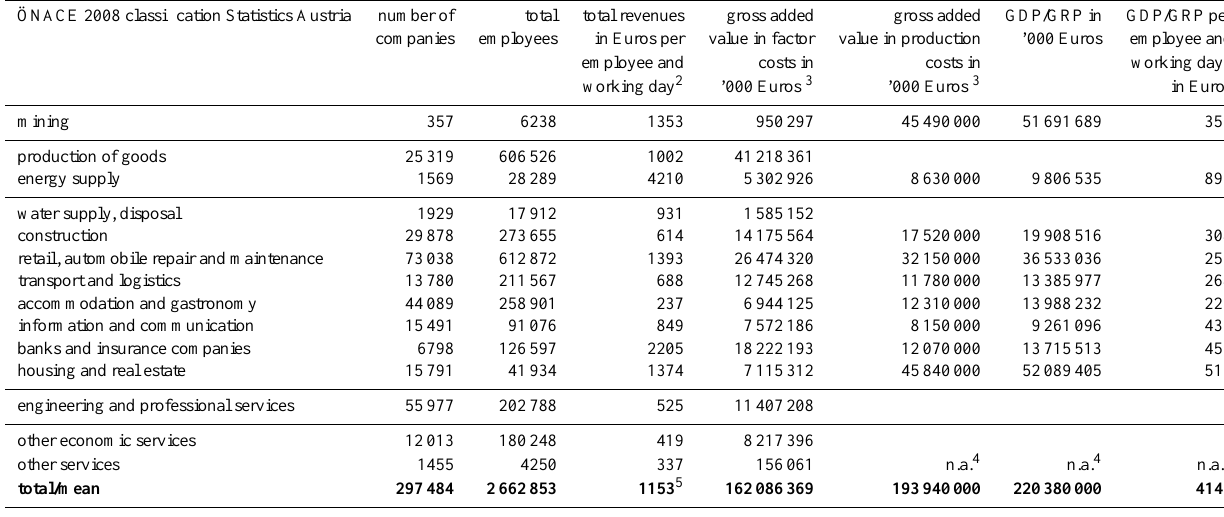
Table A3. Calculation of GDP/GRP in Euros per employee and working day and per economic sector based on the main data of the structural business statistics from Austria 2008 ÖNACE classification for private economic sectors 1 . Source: Statistics Austria and the authors’ own